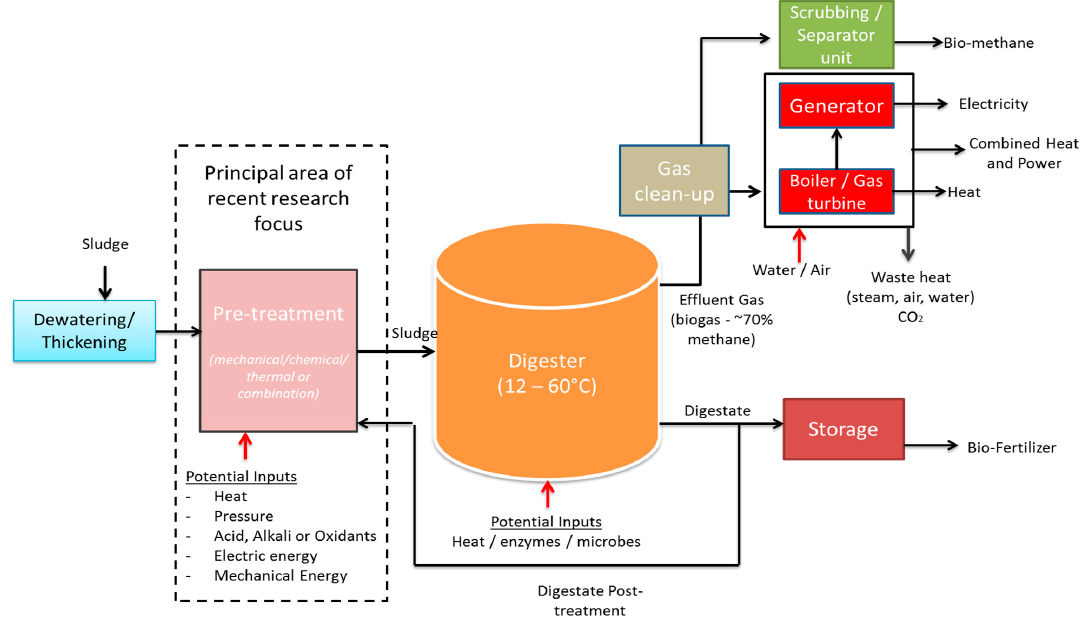
Figure 3. Schematic representation of the anaerobic digestion of sludge.